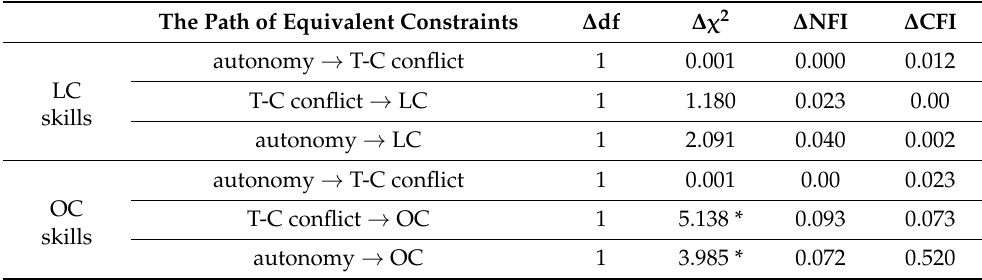
Table 3. Comparison of differences with base model.